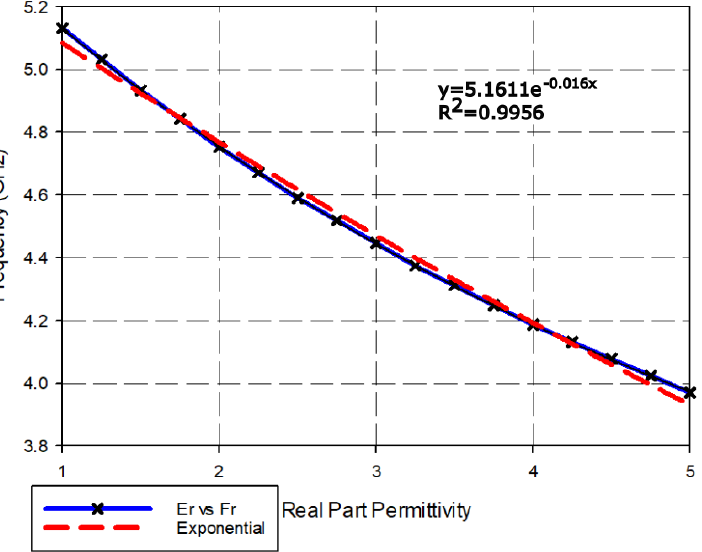
Figure 17. Plo tt ed graph of permi tt ivity versus shifted frequency when S11 is at its peak value. The permi tt ivity of a microstrip ring resonator can be modeled as an exponential function of the resonant frequency. The exponential model for the permi tt ivity of the mi- crostrip ring resonator is given by: 𝑦 = 5.1611𝑒 (cid:2879)(cid:2868).(cid:2868)(cid:2869)(cid:2874)(cid:3051) (5) where y is the resonant frequency and x is the permi tt ivity. The exponential model is based on the fact that the permi tt ivity of the microstrip ring resonator changes with frequency due to the presence of losses in the material. The losses cause the permi tt ivity to decrease with increasing frequency, which is captured by the exponential term in the equation. The relaxation time x in the exponential model is a measure of the time it takes for the material to respond to changes in the electric fi eld. It is related to the loss of tangency of the material and the conductivity of the substrate. The value of x can be determined